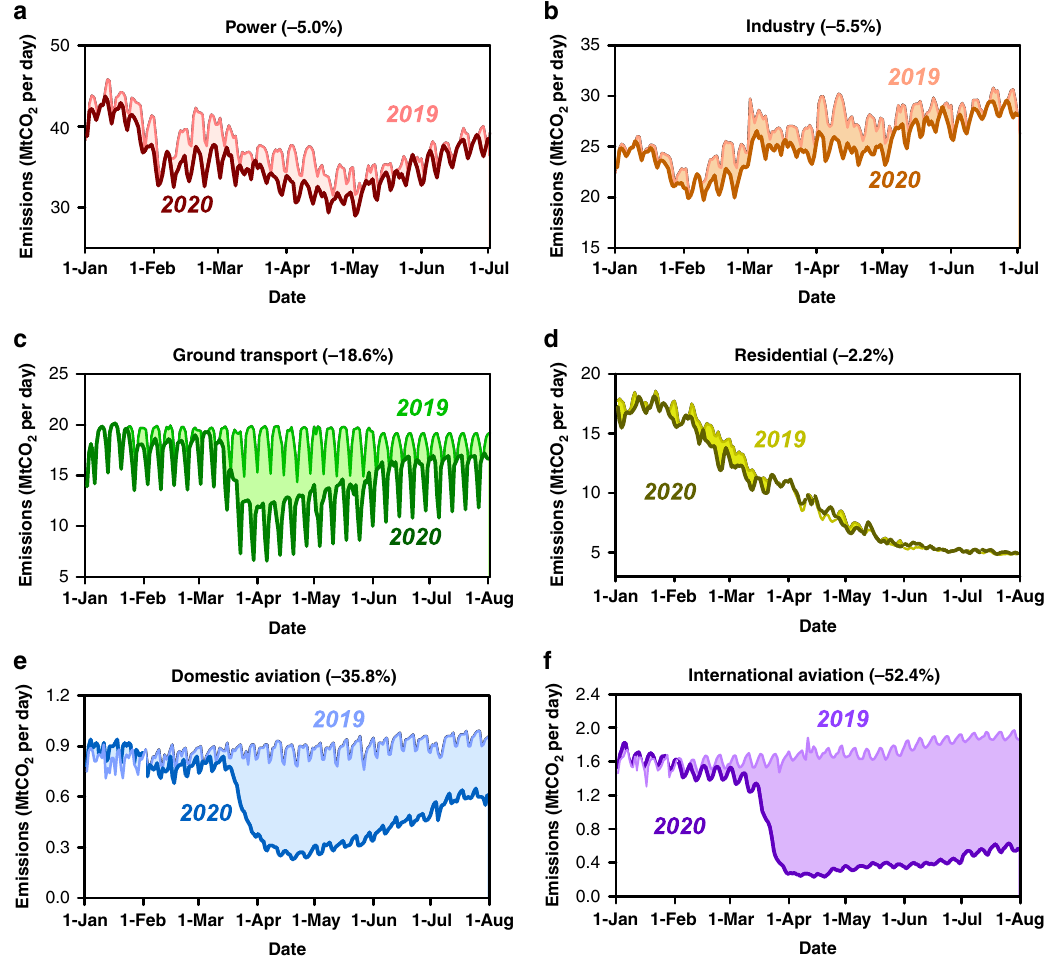
Fig. 4 Global daily CO 2 emissions for sectors. Daily CO 2 emissions by sectors in 2019 and January 1st through July 1st 2020 for a power sector and b industry sector, and January 1st through August 1st 2020 for c ground transportation sector, d residential sector, and aviation sector ( e domestic aviation; f international